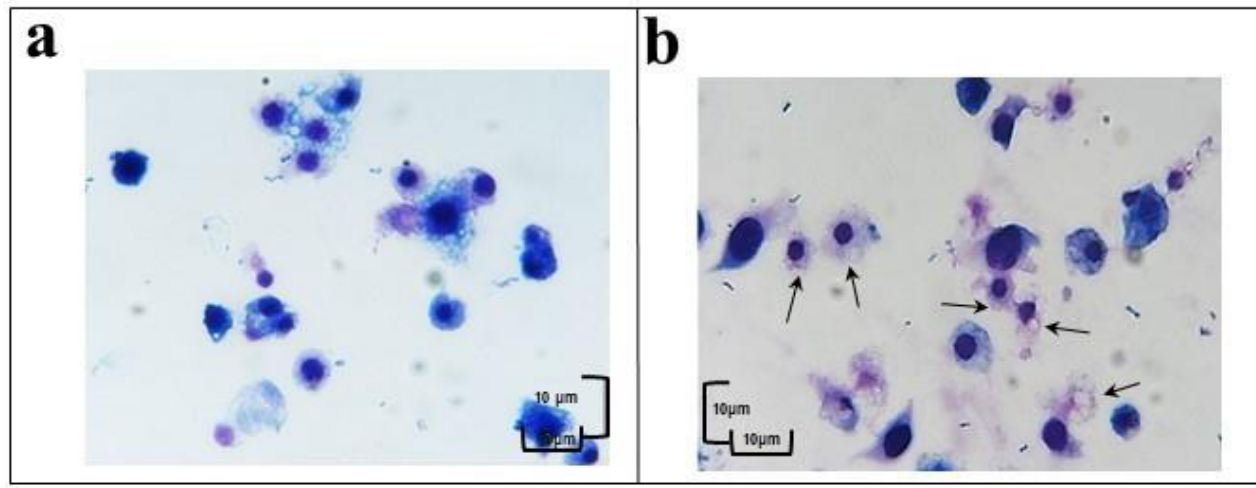
Figure 2. Haemocytes treated with 1 × PBS ( a ) or with OPs for 2 h ( b ) stained with May Grunwald–Giemsa dye. Scale bar 10 µ m. Arrows indicate vacuolization process.